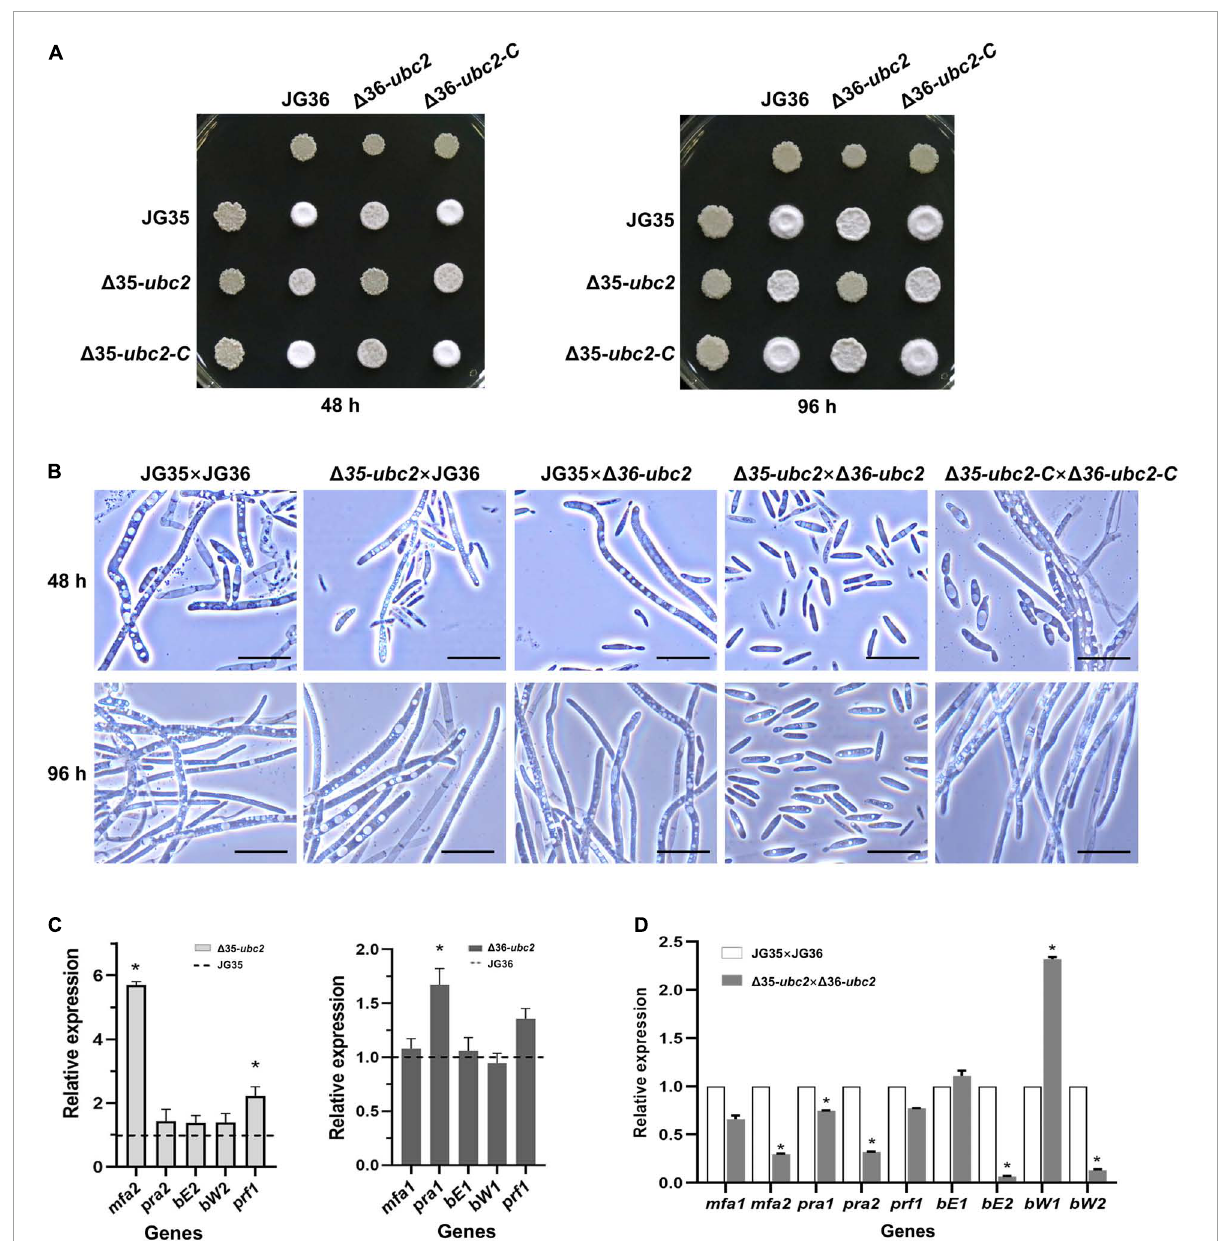
FIGURE3 Sexual mating is attenuated in Ssubc2 deletion mutants. (A) Wild-type strains, (cid:49) Ssubc2 mutants, and complementation strains were co-spotted on YEPS plates and incubated at 28 ◦ C for 48 h (left) or 96 h (right). Dikaryotic filaments formed colonies with a characteristic fuzzy white appearance. (B) Cells from a region of the colony were placed on a glass slide for observation under a microscope. Bar, 20 µ m. (C,D) Quantification of gene transcript accumulation by quantitative real-time PCR. The relative gene expression fold change was calculated with the 2 − (cid:49)(cid:49) Ct method. The actin gene of S. scitamineum was used as a control. Gene expression in the wild-type haploid strains or pairs of wild-type strains was set as 1.0. * p < 0.05.